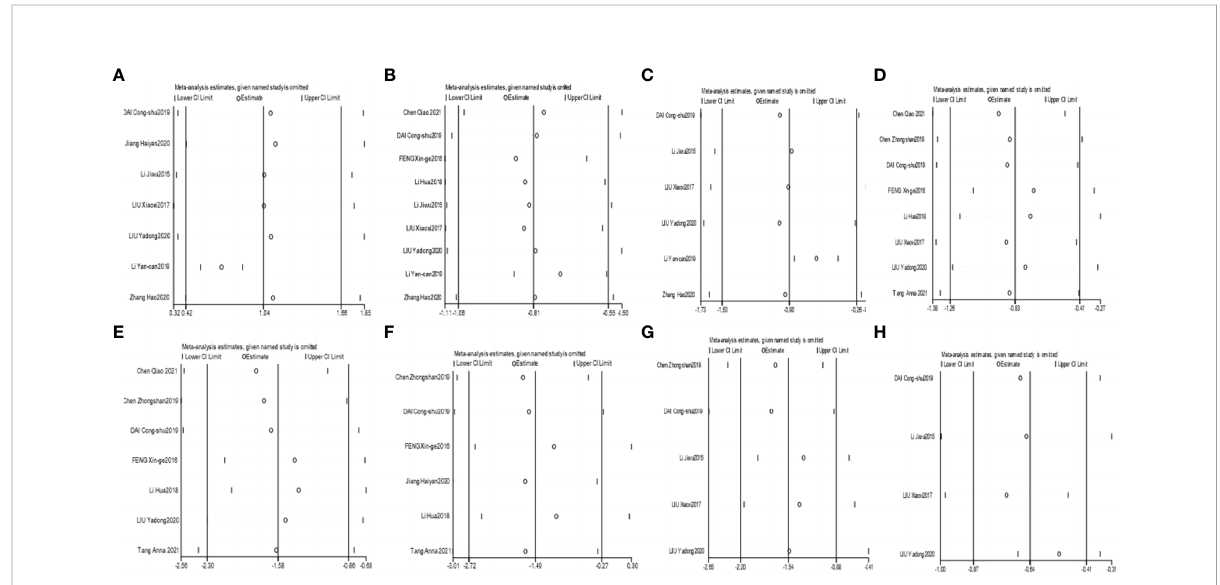
FIGURE 3 Sensitivity analyses of Bacteroidetes (A) , Enterobacteriaceae (B) , Saccharomyces (C) , FPG (D) , 2hPG (E) , HbA1c (F) , FINS (G) , and HOMA-IR (H)